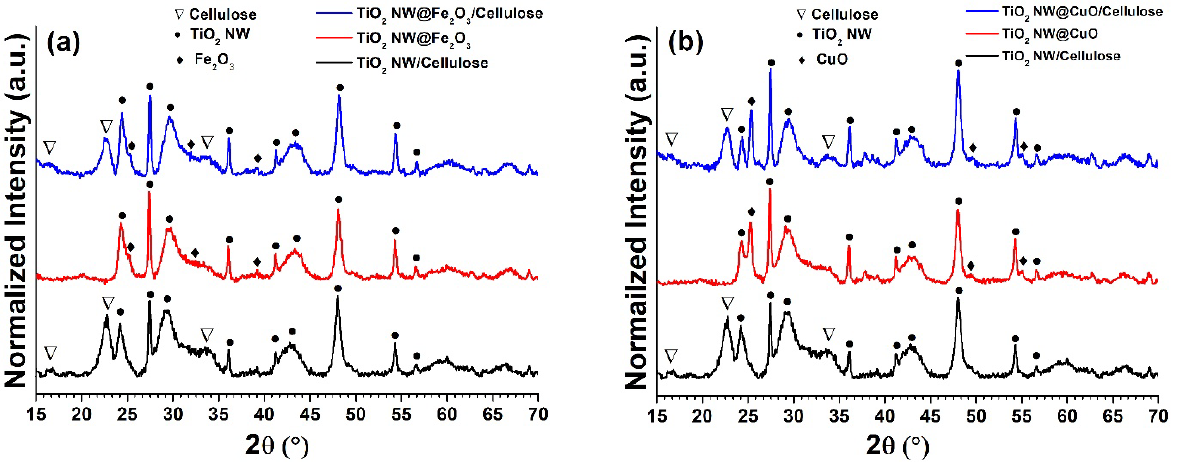
Figure 4. XRD of TiO 2 NW@Fe 2 O 3 /cellulose ( a ) and TiO 2 NW@CuO/cellulose ( b ) hybrid